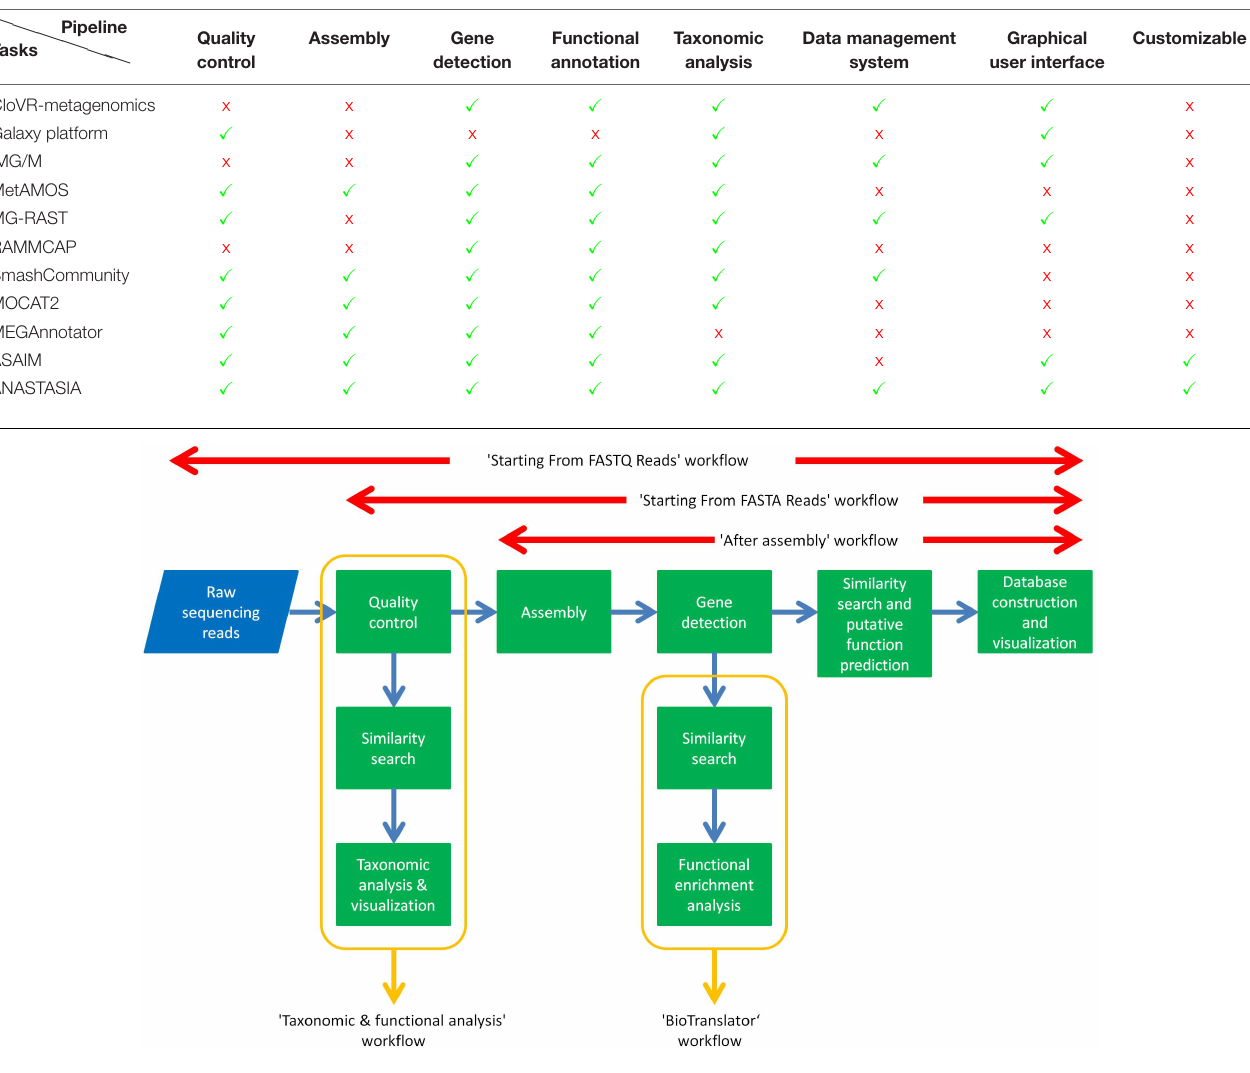
TABLE 1 | Comparison of current bioinformatic pipelines for metagenomic data analysis with ANASTASIA.